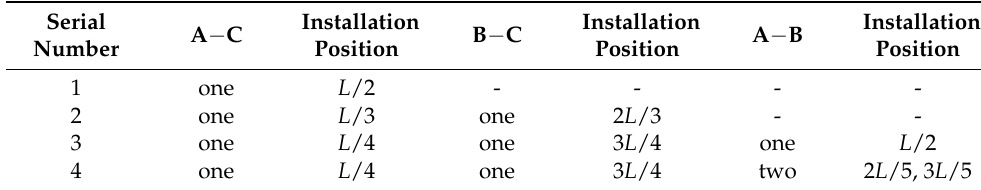
Table 3. Layout schemes of interphase spacers.